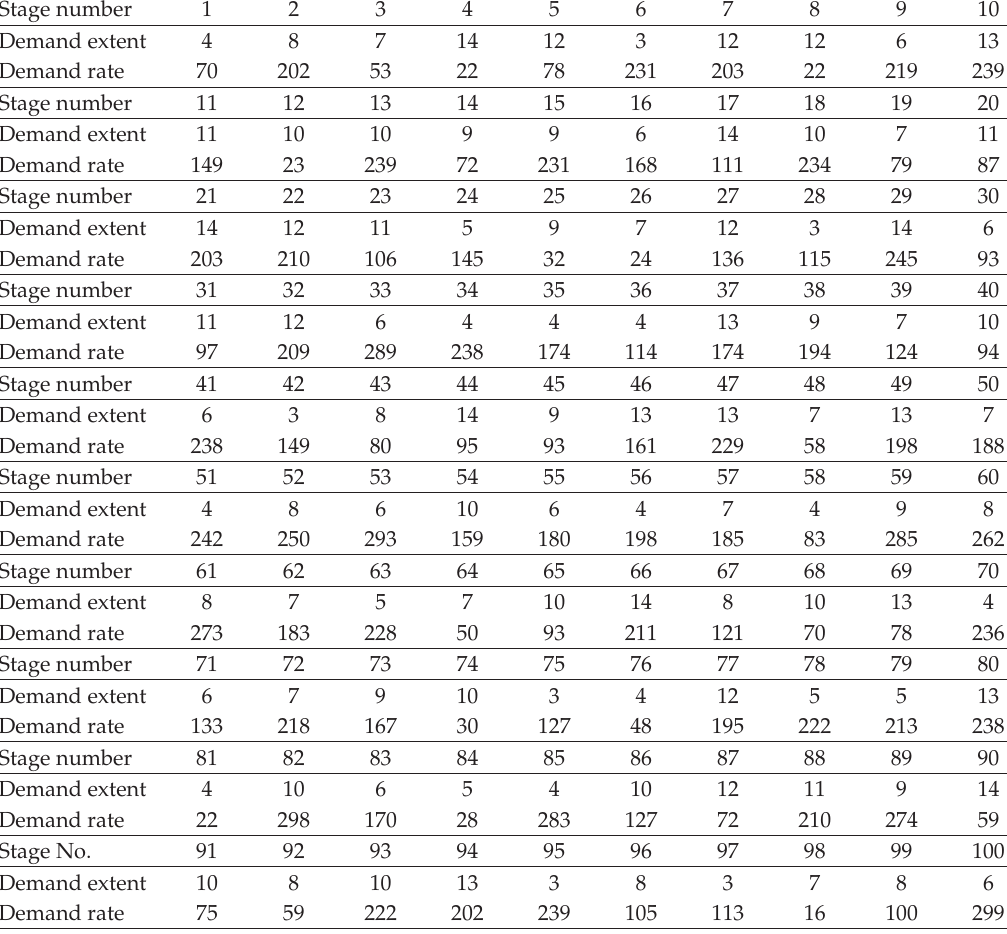
Table 4: Demand data in Problem 4.